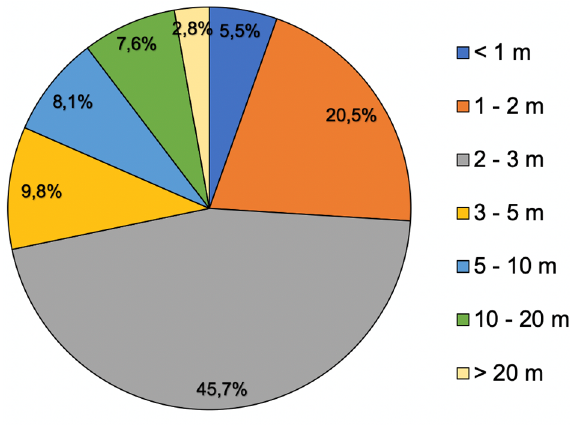
. Figure 6. Variation of Mn concentrations in the three major hydrogeological units relative to screen length ( top ) and depth of screen ( bottom ). The depth is to the middle of the screen. Dashed red line indicates the 0.3 mg/L Mn concentration.